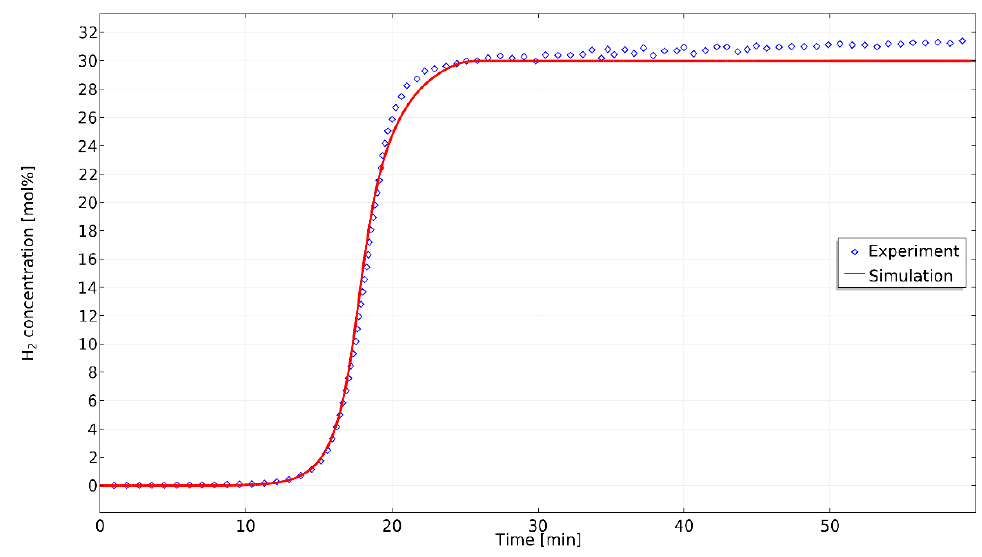
Figure 4. Experimental (blue diamonds) and model predicted (red line) H 2 breakthrough curves.